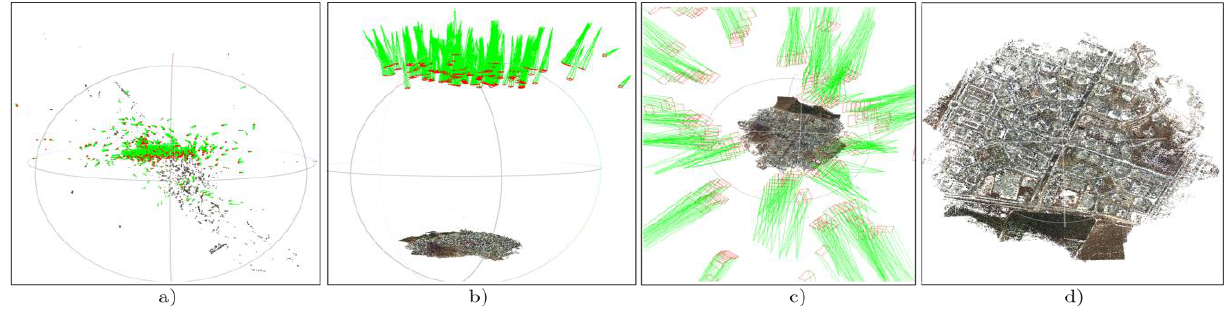
Figure 5. Image orientation results of large oblique block (VisionMap A3 dataset, 280 images) over an urban area (ca 0.5 x 0.5 km): camera poses retrieved without (a) and with connectivity graph (b, c). The sparse point cloud of the extracted tie points (d).